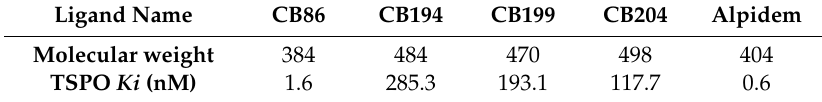
Table 1. The a ffi nity data of translocator protein (TSPO) ligands used in the current